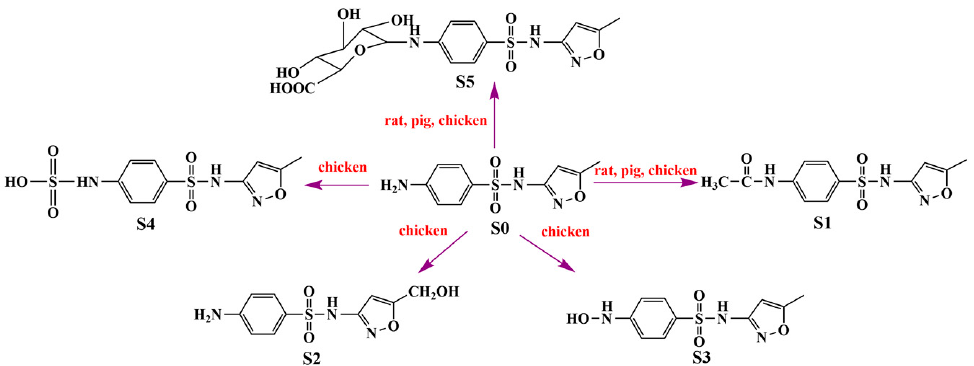
Figure 5. Proposed metabolic pathway of SMZ in animals. Glucuronidation and acetylation are common metabolic pathways in pigs, chickens and rats. Hydroxylation and sulfate conjugation are unique metabolic pathways for chickens.